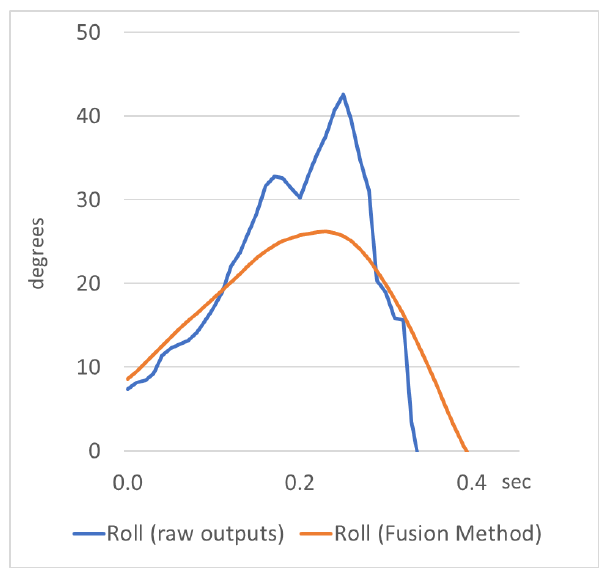
Figure 9. Absorption of sudden movements of the mobile device using the fusion method.